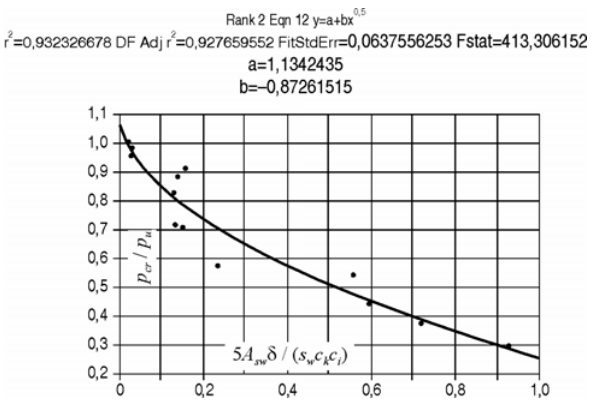
Fig 7. Variation of the ratio p cr / p